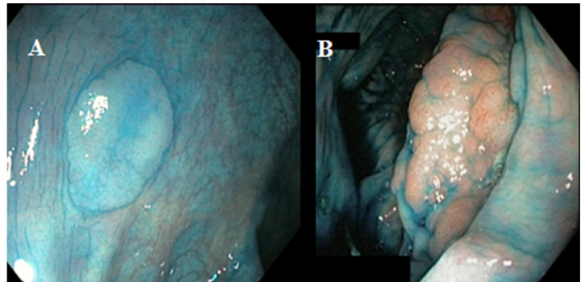
Figure 3. Endoscopic pictures of non-neoplastic (panel ( A )) and neoplastic (panel ( B )) lesions.